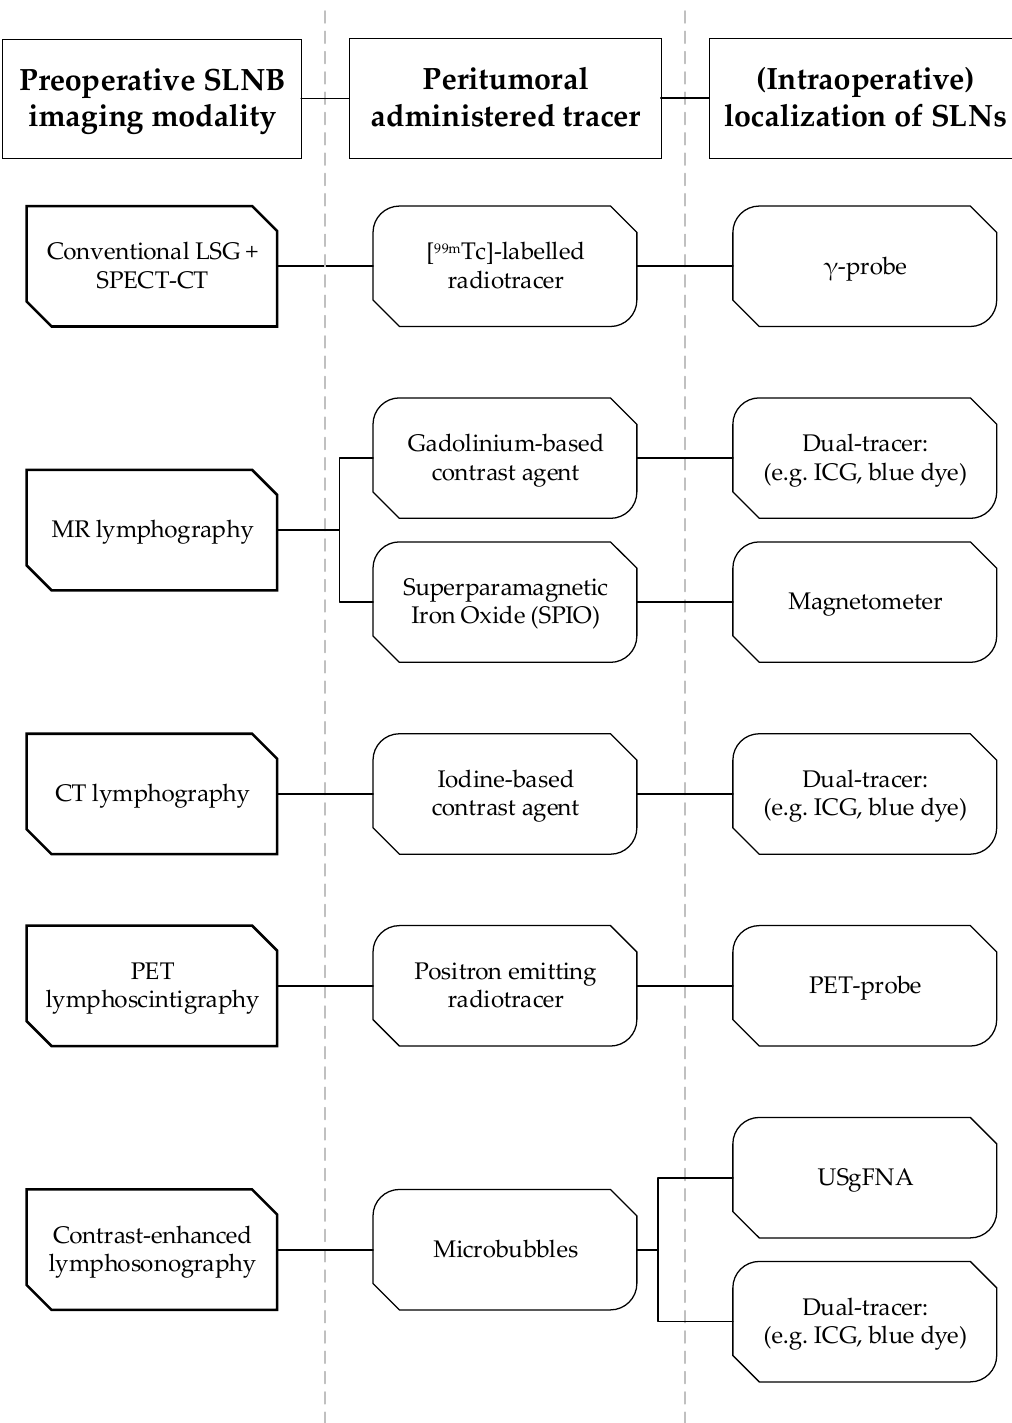
Figure 2. Overview of the reviewed preoperative SLN imaging techniques (column 1), the administered tracers for the corresponding techniques (column 2) and their intraoperative SLN localization techniques (column 3) as described in literature. SLNB; sentinel lymph node biopsy, LSG; lymphoscintigraphy, SPECT-CT; single photon emission computed tomography-computed tomography, MR; magnetic resonance, CT; computed tomography, PET; positron emission tomography, ICG; indocyanine green, USgFNA; ultrasound guided fine needle aspiration.